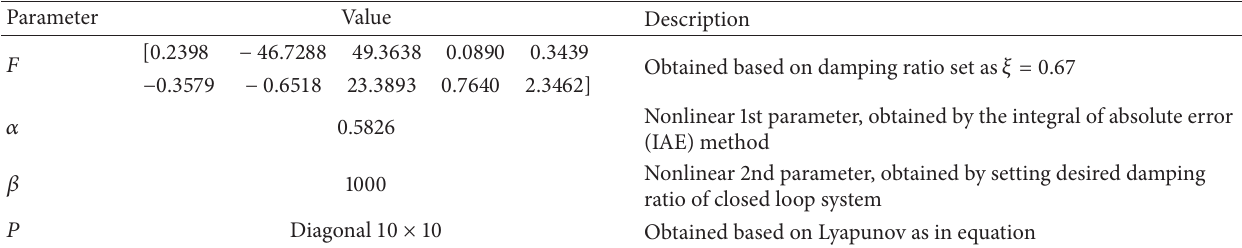
Table 1: Numerical parameters for CNF controller.